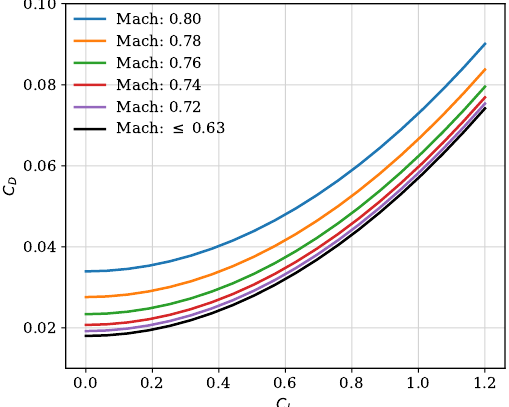
Figure 4. Changes of drag polar due to compressibility